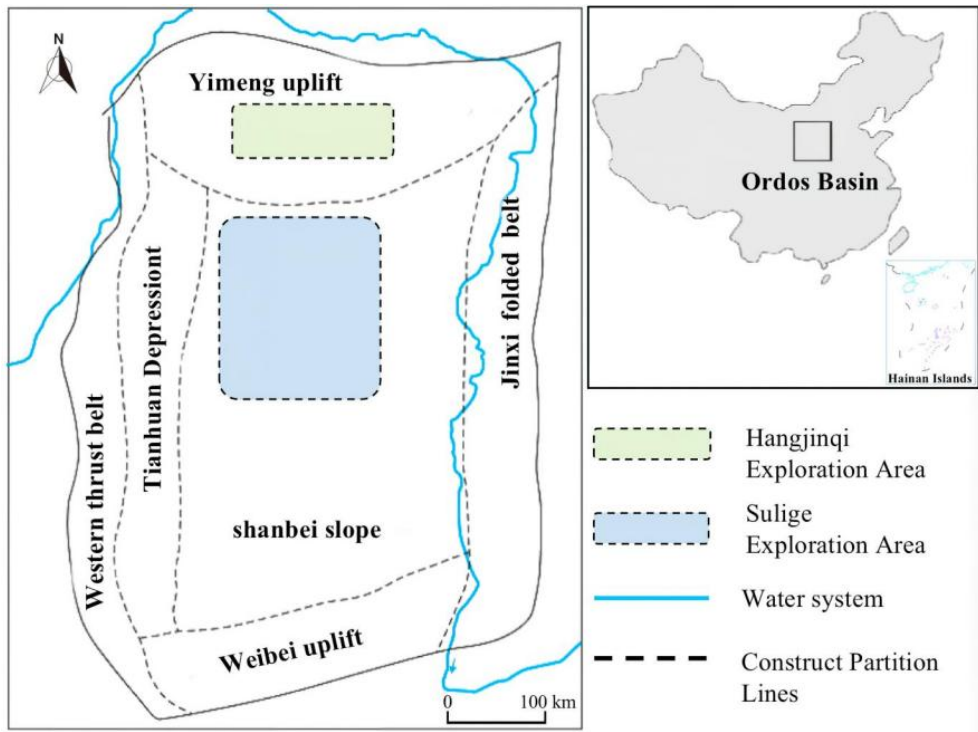
Figure 3. Classification of fluvial facies in